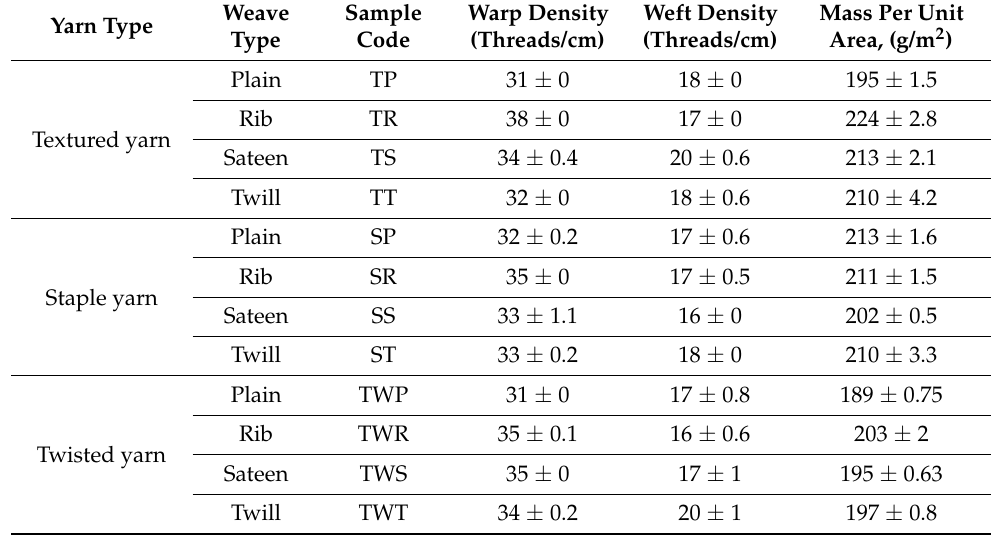
Figure 1. Types of fabric weave interlacement. Table 1. Fabric construction parameters [20].